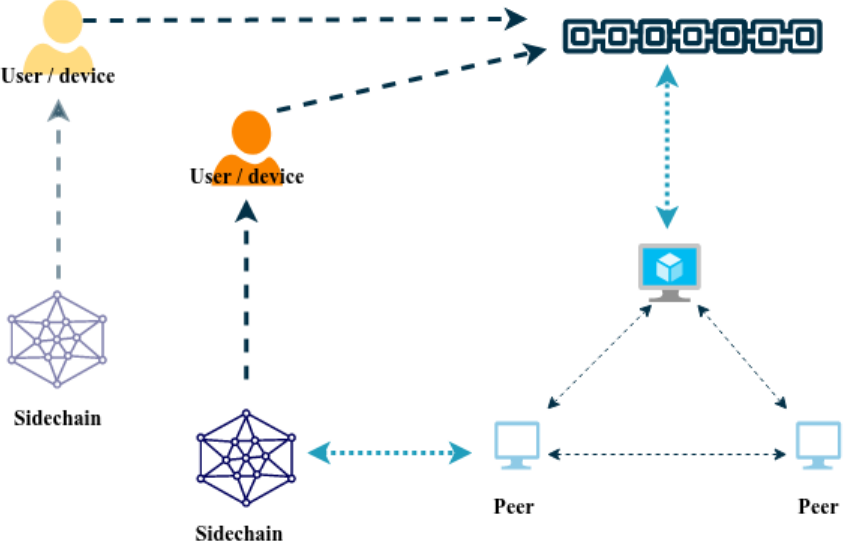
Figure 3. Sidechain